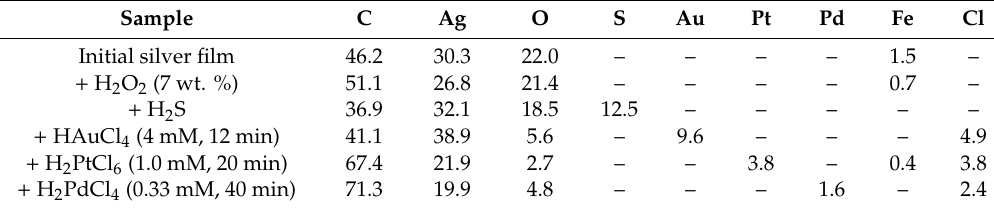
Figure 2. SEM image and X-ray photoelectron spectra of silver nanoparticles (Ag NPs) deposited from Carey Lea hydrosol and exposed with H 2 S via gas phase transfer for 30 min. For comparison, the Ag 3d and Ag M 5 NN spectra of the intrinsic nanoparticles (Figure 1) are shown as green lines. Table 1. Atomic concentrations found using XPS for the silver films before and after different chemical treatment.